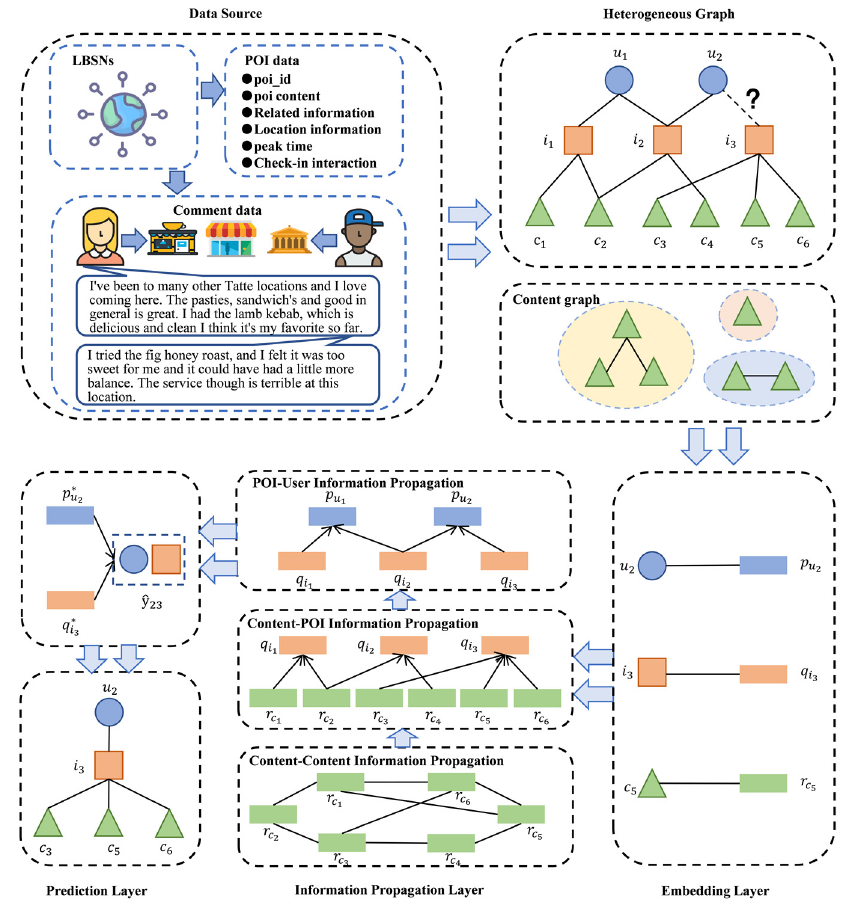
Figure 2. The framework of FP-MGCN model.